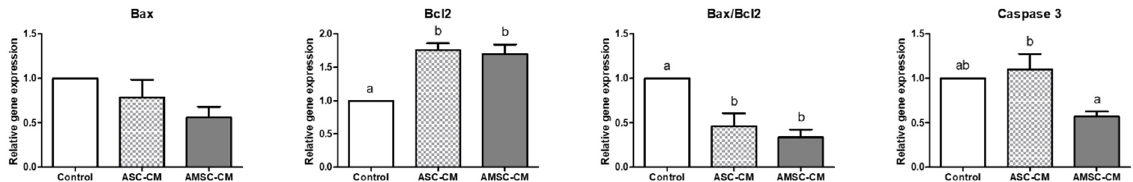
Figure 7. Relative apoptosis-related gene expression in blastocysts cultured in the control, human adipose-derived mes- enchymal stem cell conditioned medium (ASC-CM) and amniotic membrane-derived mesenchymal stem cell conditioned medium (AMSC-CM) group. Data are normalized to housekeeping gene 18S rRNA and presented as mean ± standard error of the mean (SEM). Superscript letters in each column indicate significant differences ( p < 0.05).